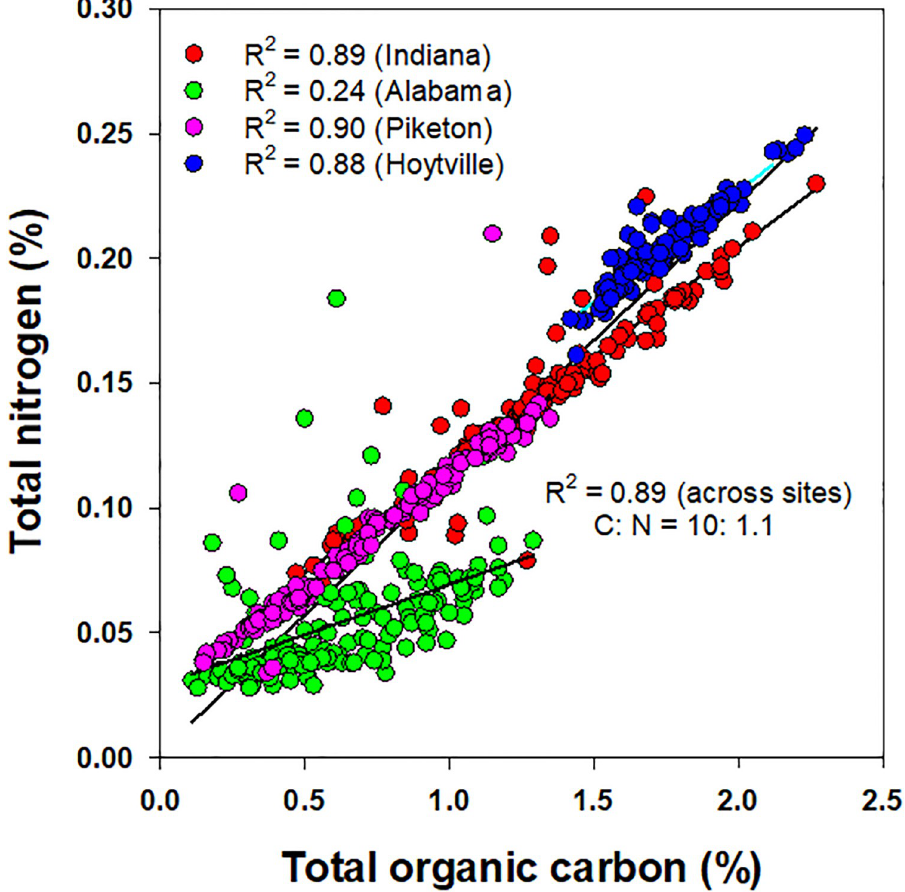
Fig 2. Relationship between soil total organic carbon (SOC) and total nitrogen (TN) content for a gypsum- amended rainfed transitional no-till soybean-corn rotation with cover crop in Alabama (Shorter), Indiana (Farmland), and Ohio (Hoytville and Piketon) and averaged across all